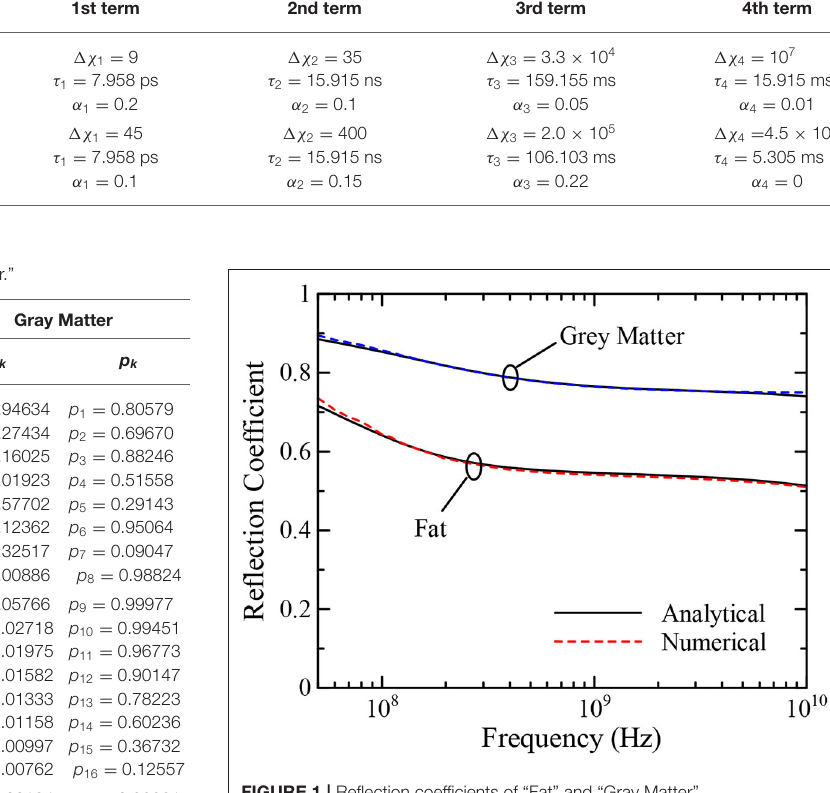
FIGURE 1 | Reflection coefficients of “Fat” and “Gray